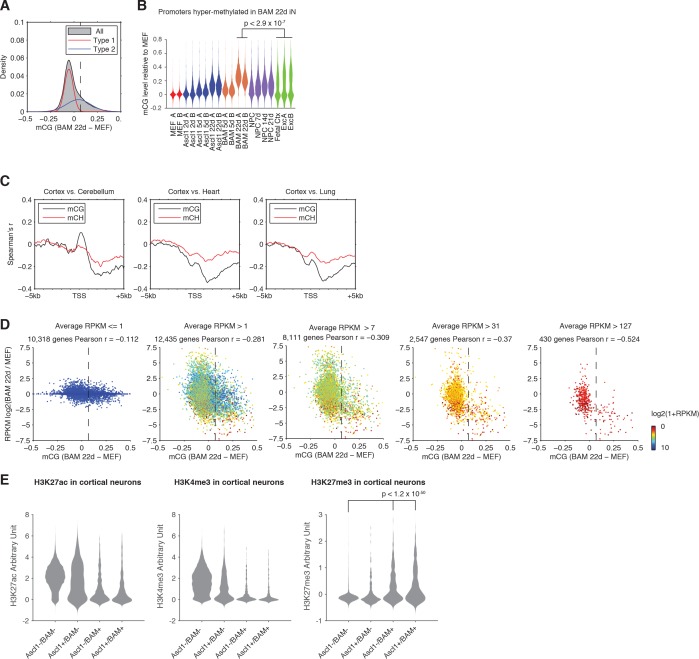
Direct reprogramming induces distinct promoter CG methylation accumulation. (A) Probability density of normalized mCG changes (BAM 22d – MEF) for 1 kb regions surrounding TSS. A Gaussian mixed model with two components was fitted to the data and resulted in two distributions (type A and B) with μ values of −0.0551 and 0.0485, σ values of 0.0021 and 0.0169 and weights of 0.5559 and 0.4441, respectively. The threshold of hyper-mCG TSS was determined to be 0.0691. (B) mCG level of promoters showing hyper-methylation during direct reprogramming induced by BAM compared to in vivo grown cell. mCG levels were normalized to that of MEF. (C) Correlation between mCG change and differential gene expression between cortex, cerebellum, heart, and lung in ±5 kb regions surrounding TSS. (D) Scatter plots of promoter mCG change against differential gene expression between BAM 22d iN cells and MEF for genes with average RPKM <= 1,>1,>7,>31 and>127. The vertical dashed line indicates the threshold of promoters showing significant hyper CG methylation. There is a strong inverse correlation between promoter hyper CG methylation and gene expression change. (E) All promoters were separated into four categories depending on their hyper-mCG states in Ascl1 22d iN or BAM 22d iN cells. Violin plots show H3K27ac, H3K4me3 and H3K27me3 levels of the four types of promoters in cortical neurons to explore their chromatin states in in vivo grown cells.